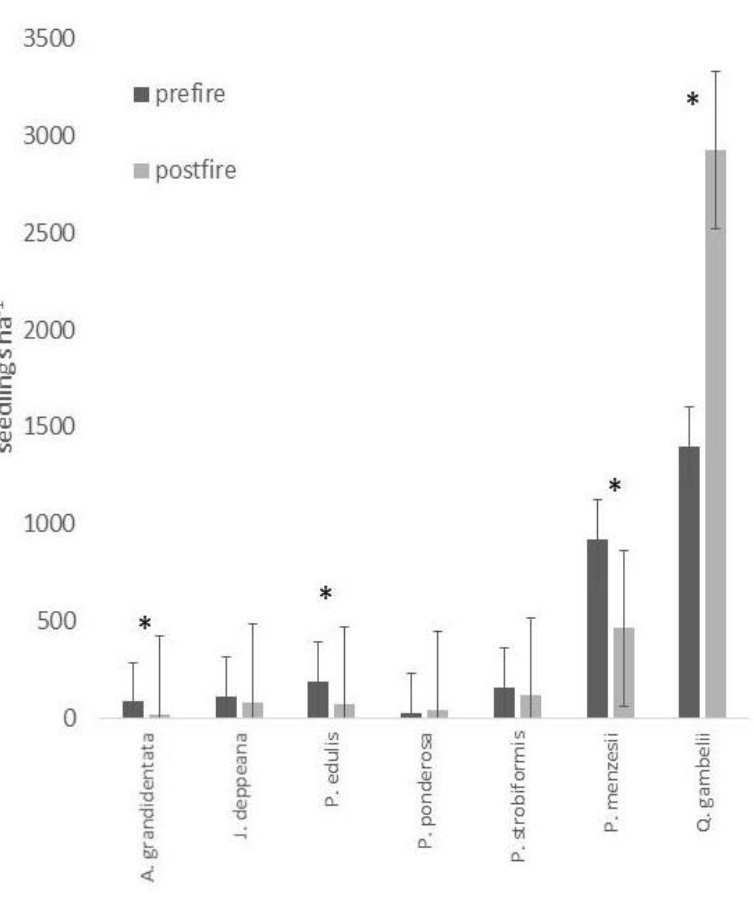
Figure 4. Mean seedling abundance (# ha − 1 ) by species (+1 S.E.) for the pre- and post-fire sampling intervals in Guadalupe Mountain National Park, Texas. Asterisks signify significant paired t -tests at p < 0.05.